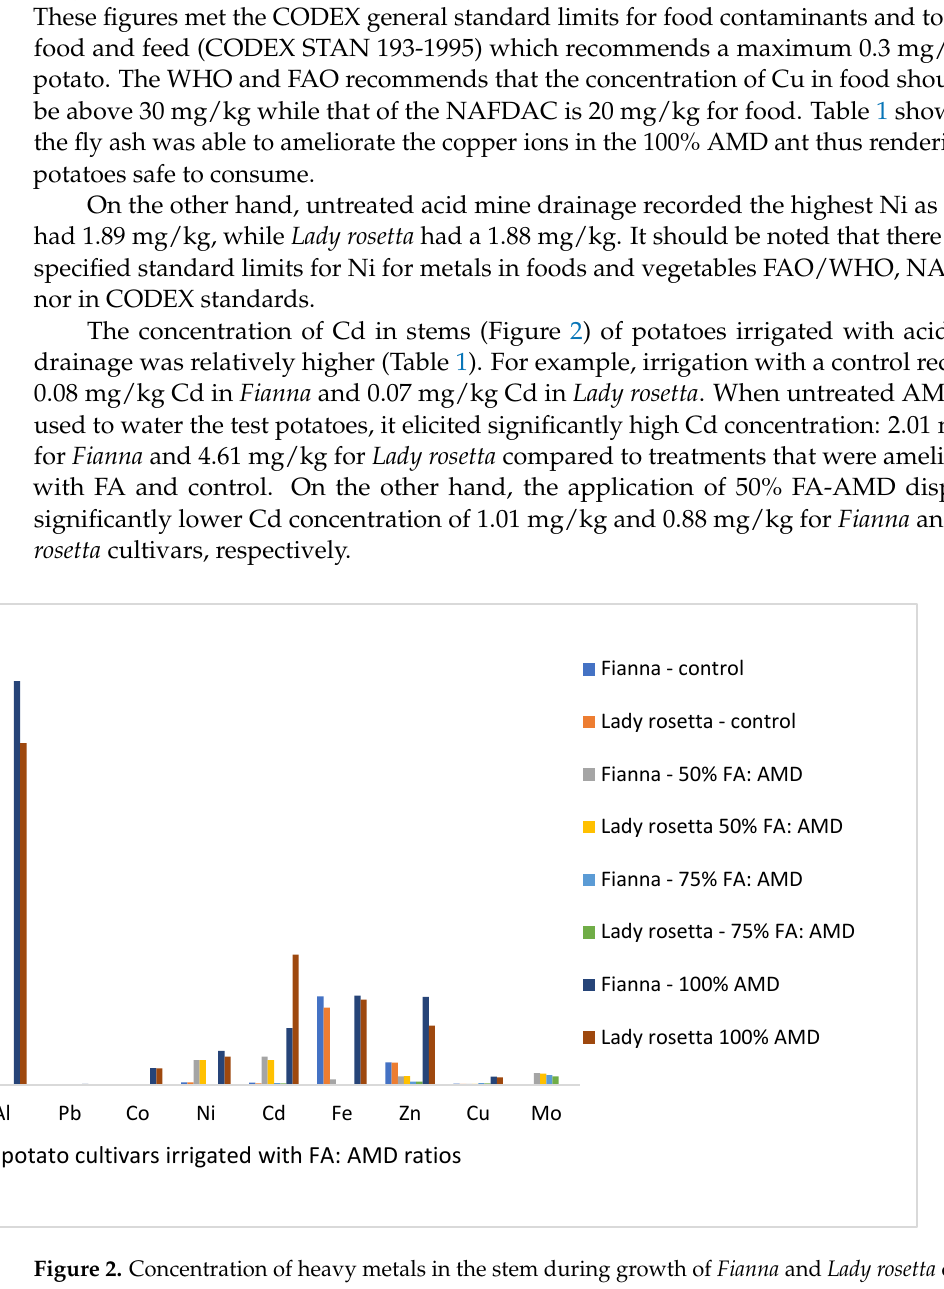
Figure 2. Concentration of heavy metals in the stem during growth of Fianna and Lady rosetta cultivar irrigated with acid mine drainage.